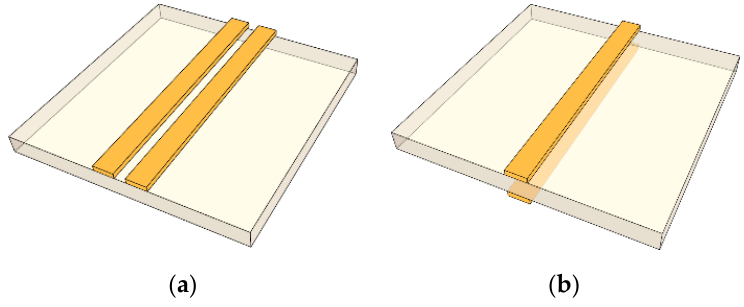
Figure 5. Perspective views of the balanced lines: ( a ) CPS, ( b ) PSL.